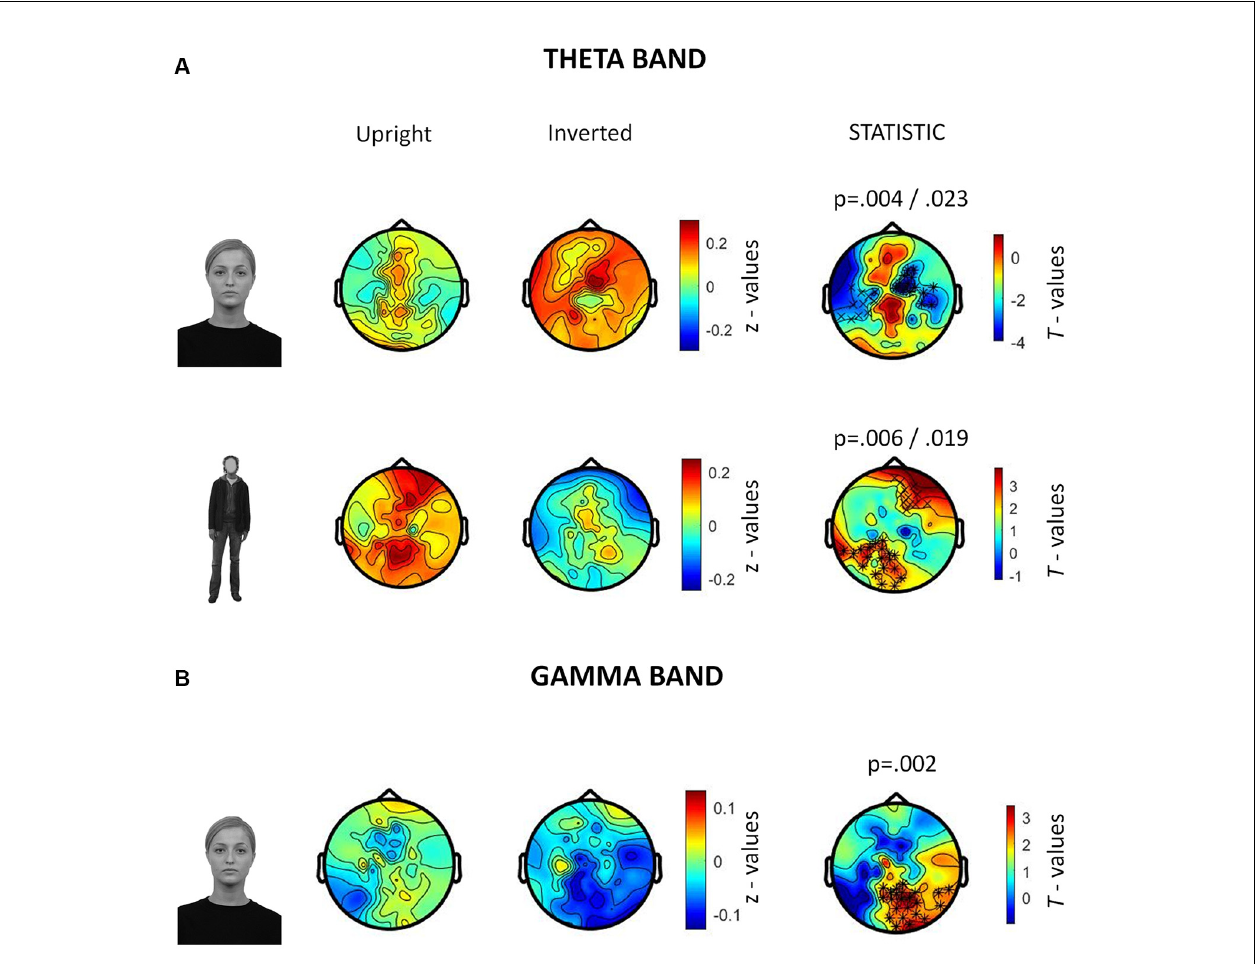
FIGURE 5 | Summary of results related to the induced activity. All topographies were obtained by calculating the average power over the TOI for induced activity (i.e., 250–500 ms after stimulus onset). (A) Topographies show the activity induced by upright and inverted faces (first row) and bodies (second row) in the theta band (5–7 Hz). The third column of topographies shows clusters where statistically significant differences between upright and inverted stimuli were found by means of non-parametric cluster-based permutation tests. Increased theta synchronization is highlighted for inverted faces (vs. upright faces) over a right frontoparietal and a left parietal cluster, whereas upright bodies (vs. inverted bodies) induced a significantly stronger theta synchronization over a left-lateralized occipito-temporal cluster and a right prefrontal cluster. (B) Topographies representing gamma-band (28–45 Hz) activity induced by upright and inverted faces are shown. The statistical comparison highlighted a stronger gamma synchronization for upright faces (vs. inverted faces) over the right occipito-temporal